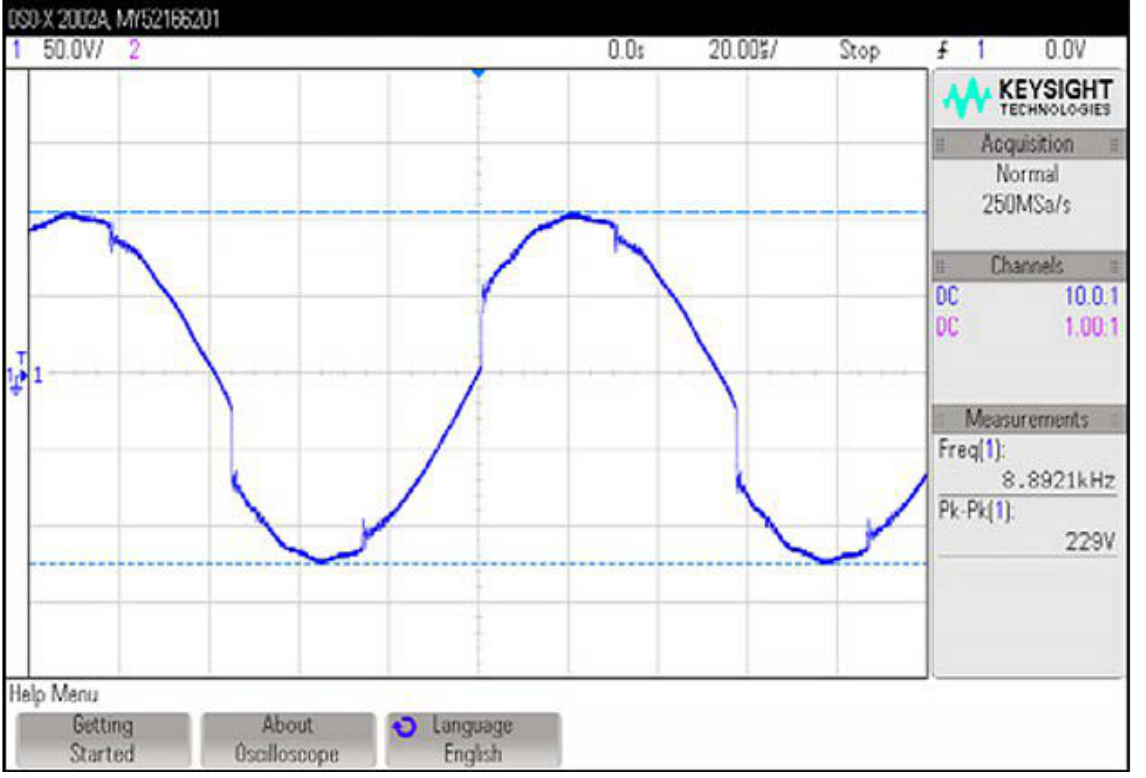
Figure 13. Signals of heaters applied to the bioreactor at a frequency of 8.892 kHz. Table 1. Changes in the current when the voltage of the induction heating apparatus is increased different times to measure the value of the current drawn by the load, the temperature when using 4 induction heating apparatuses.